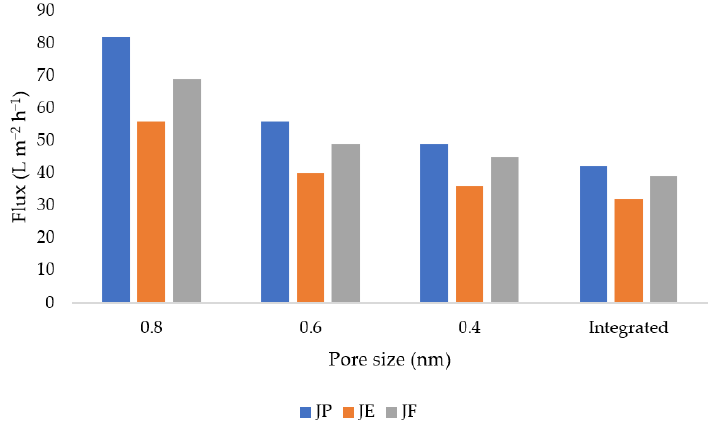
Figure 6. Presentation of different types of fluxes.